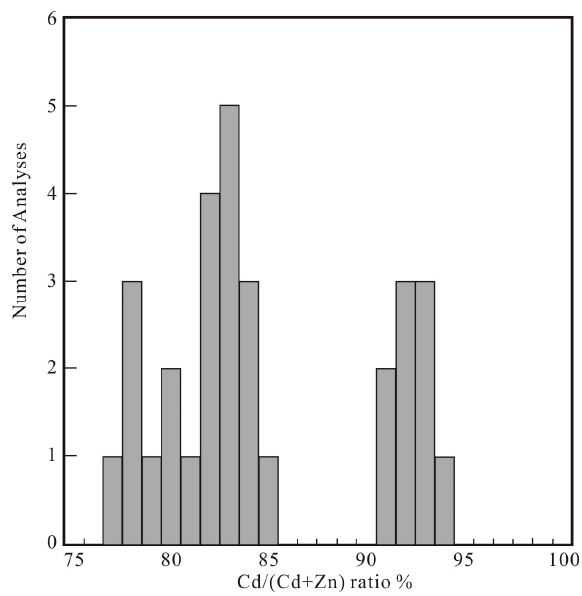
Figure 8. Histogram of the Cd/(Cd+Zn) ratio of zincian greenockite of the Saishitang deposit.